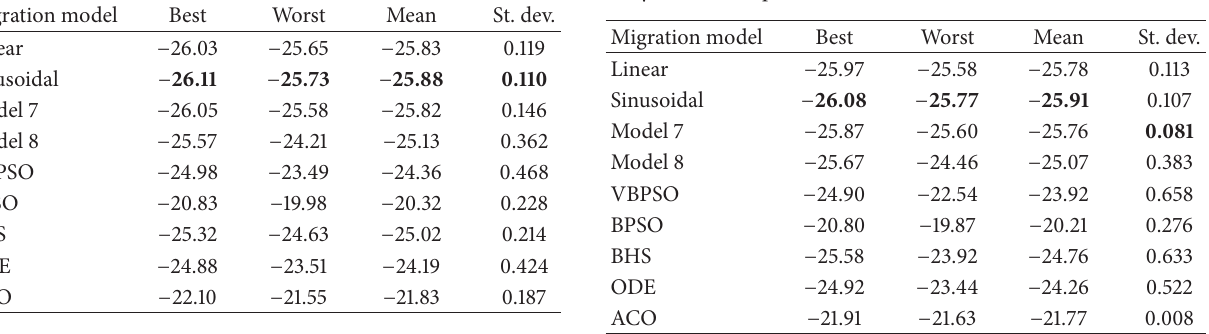
Figure 6: Radiation pattern of the best obtained array for the 300- element asymmetric thinned array. Table 6: Comparative results for 300-element asymmetric thinned array with same aperture size. The smaller values are in